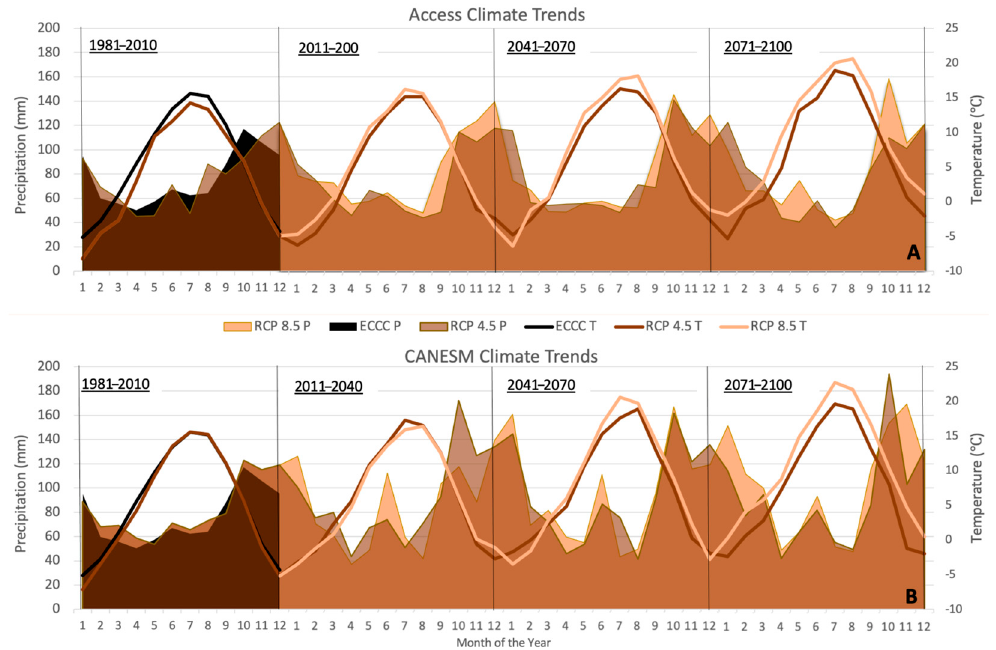
Figure 5. Basin-averaged, monthly climate normal (30-year averages) from ( A ) ACCESS GCM and ( B ) CANESM GCM and RCP 4.5 and 8.5 emission scenarios. Also shown is basin-averaged, measured monthly data derived from ECCC climate stations for the 1981–2010 climate normal. The differences between the two RCPs become first distinguishable after the reference period and thus only RCP 4.5 results are shown in the reference period.